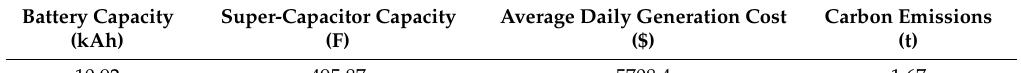
Table 1. Summary of optimal system operation parameters of point P.